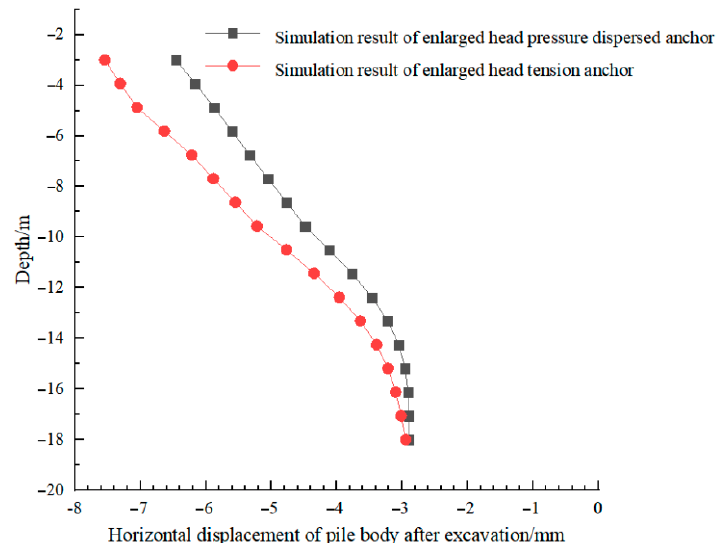
Figure 25. Pile body displacements.